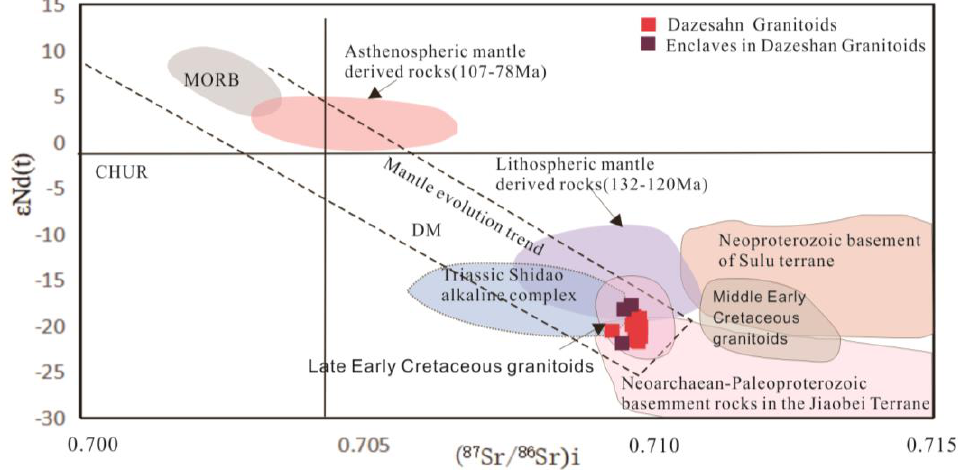
Figure 8. ( 87 Sr/ 86 Sr) i vs. ε Nd(t) diagram for Dazeshan granitoids and their enclaves. Data sources: MORB [68]; Mafic dikes derived from lithospheric mantle (132–120 Ma) from [28,47,69]; Mafic rocks derived from asthenospheric mantle (107–78 Ma) from [34,70]; Neoarchaean-Neoproterozoic basement rocks in the Jiaobei Terrane from [71]; Neoproterozoic basement rocks in the Sulu Terrane from [38]; Triassic Shidao alkaline complex from [72]. CHUR: chondritic uniform reservoir; MORB: middle ocean ridge basalt; DM: depleted